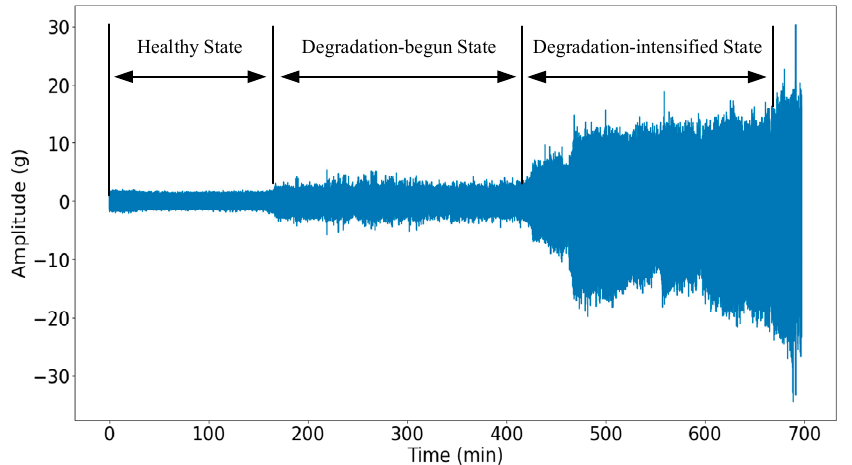
Figure 2. Changes in time-domain data of the machinery in different performance states.